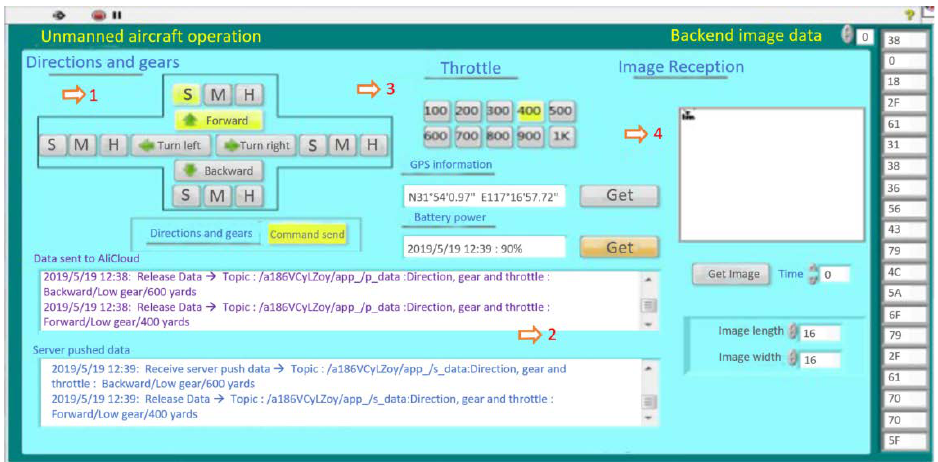
Figure 12. User interface connects with cloud platform through mqtt protocol to control Internet of things UAV. Table 1. Experimental data of logistics